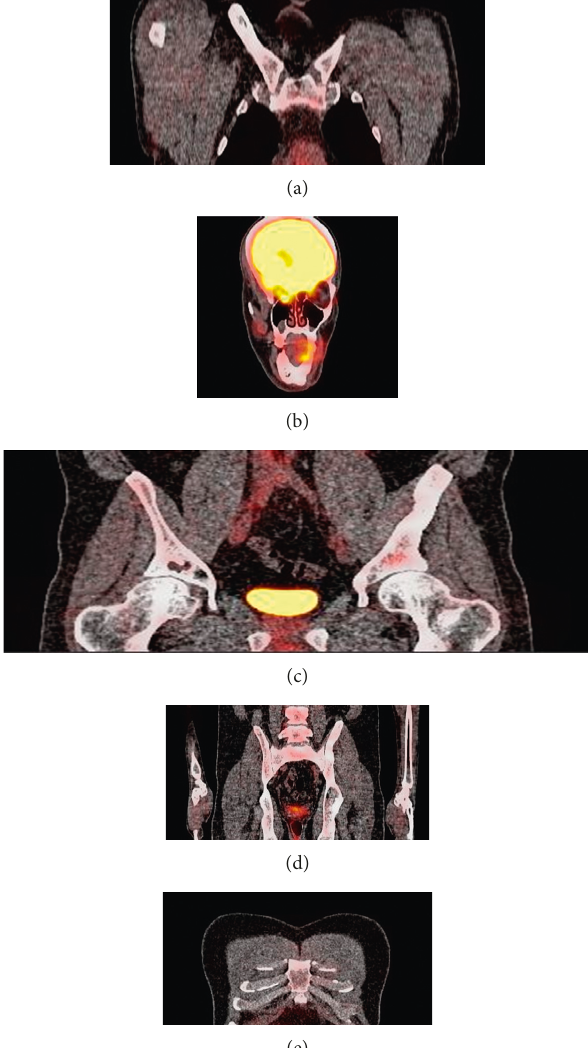
Figure 2: PET CT imaging without metabolic activity in stable lesions and no new lesions. (a) Right clavicle, (b) mandible region, (c) hip and pelvis, (d) pelvis and sacroiliac joint, and (e)